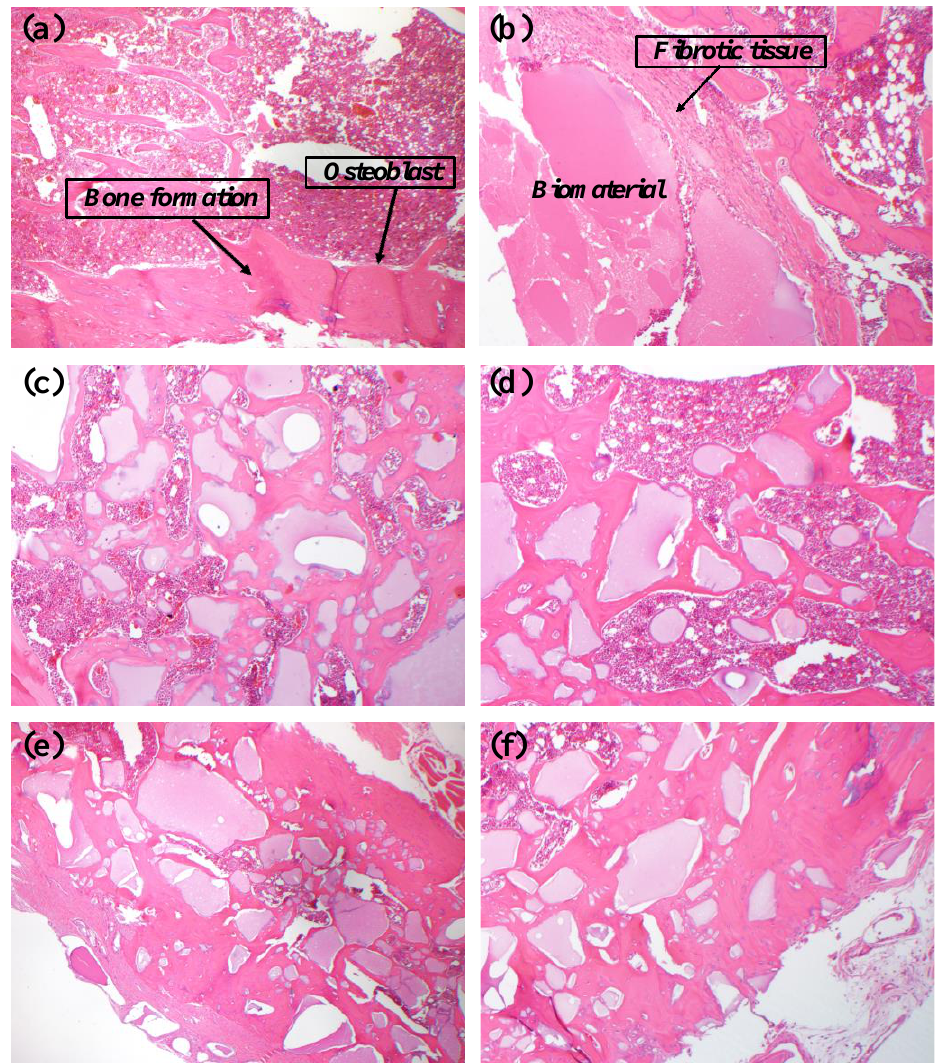
Figure 7. Histopathological images of groups ( a ) Control, ( b ) SAP, ( c ) SAP-F5, ( d ) SAP-F10, ( e ) SAP-F30, and ( f ) SAP-F0.